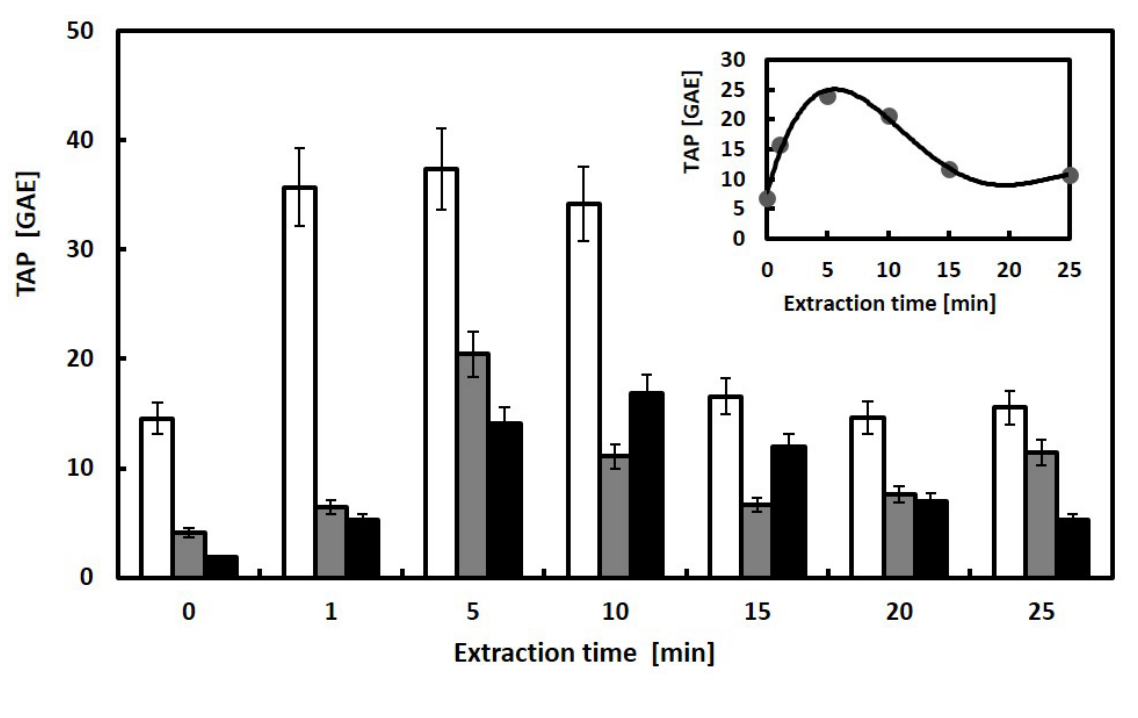
Figure 6A: The dependence of TAP values on the time of extraction in methanol. Meat samples (500 mg/mL): sirloin of beef (white), chicken fillet (gray), pork shoulder